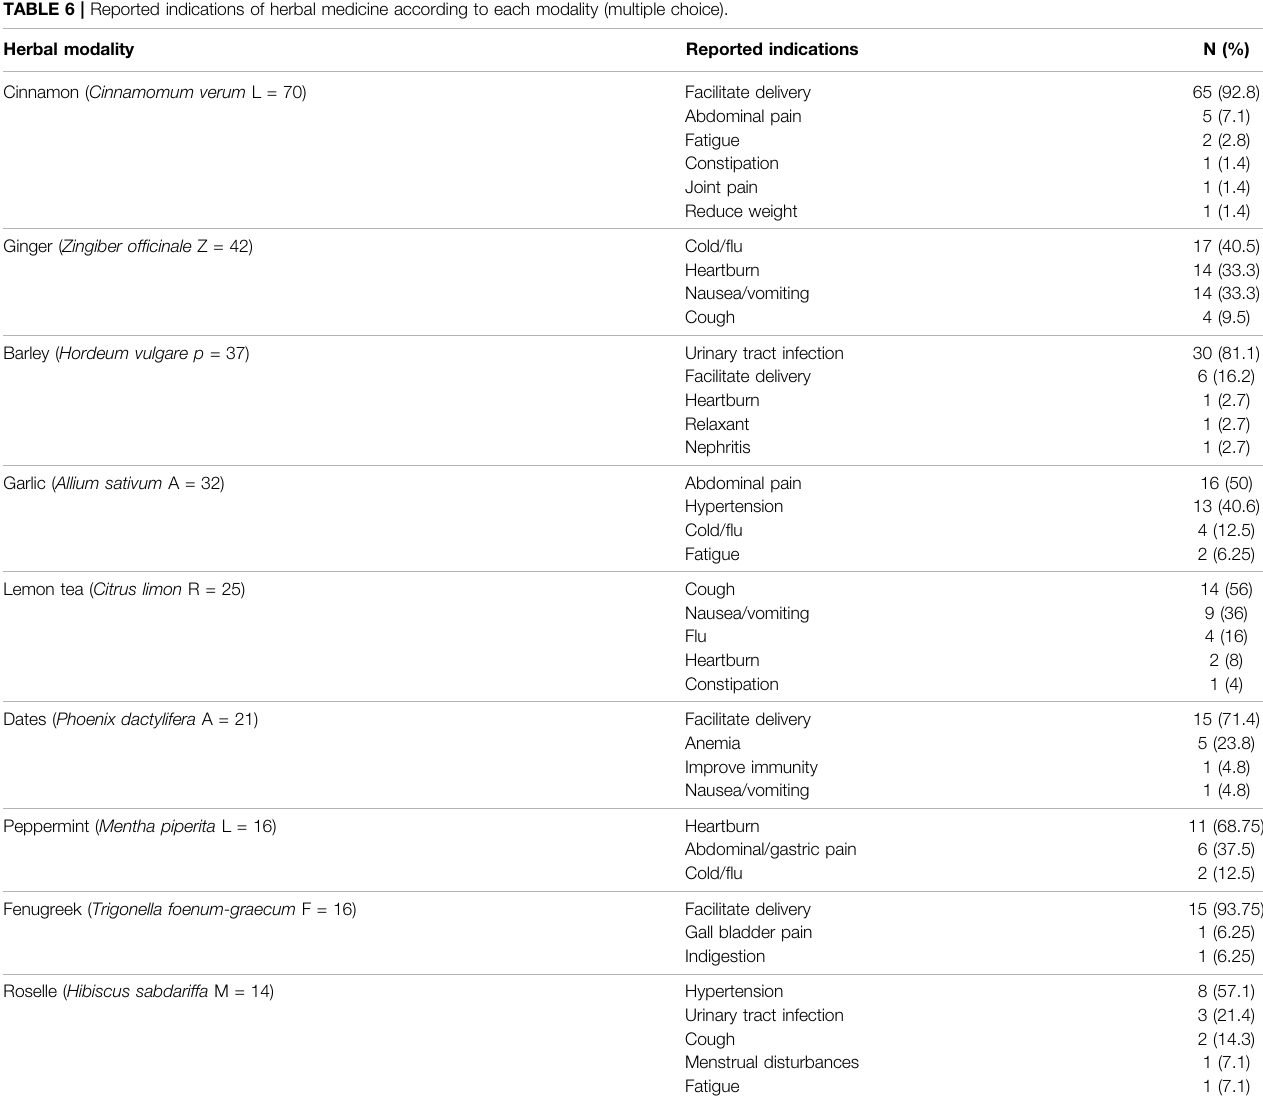
TABLE 6 | Reported indications of herbal medicine according to each modality (multiple choice). Herbal